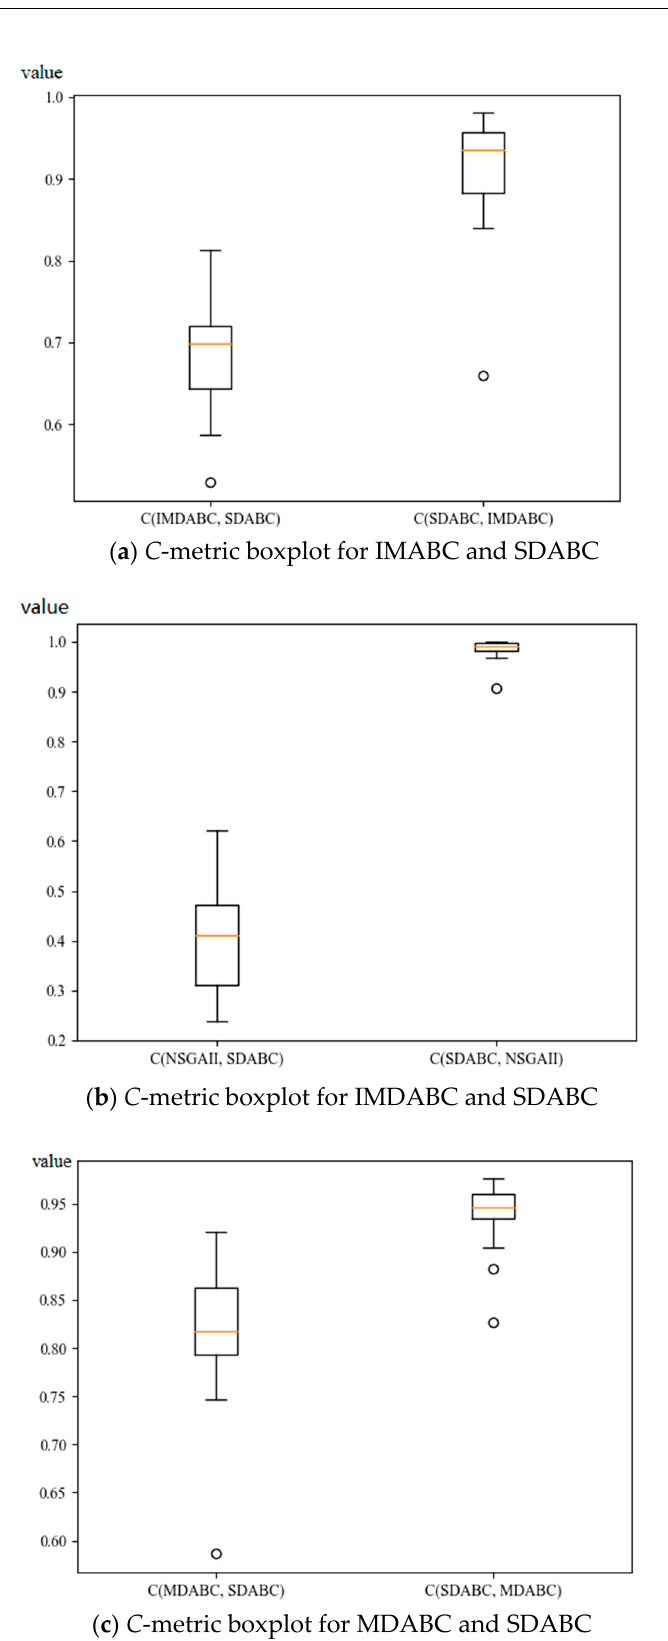
Figure 6. C -metric boxplot for NSGAII, IMDABC, MDABC, and SDABC.